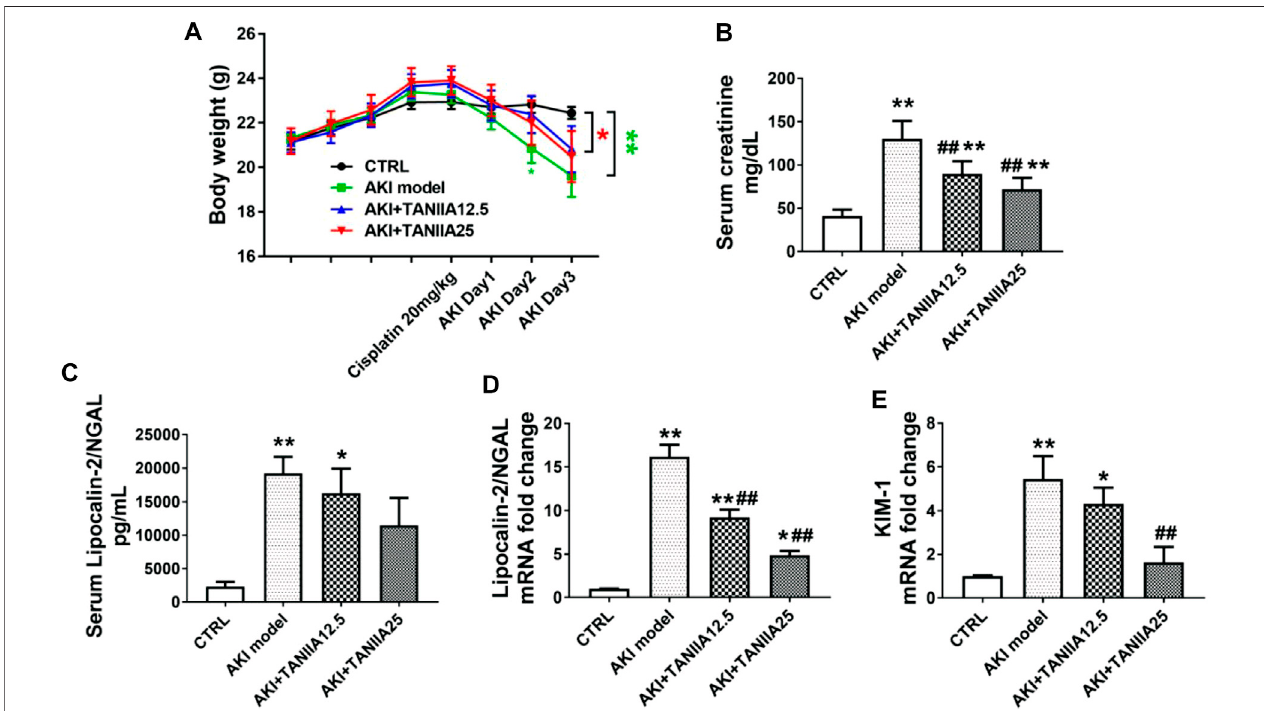
FIGURE 2 | TanIIA treatment restores renal function in cisplatin-induced AKI. (A) Body weight (g) before and after cisplatin injection. (B) Serum creatinine at 72 h aftercisplatin(20 mg/kg)injection. (C) BarchartrepresentstheserumlevelofNGAL. (D,E) mRNAlevelofNGAL,KIM-1inthekidney.Datarepresentasmean±SEM, *p < 0.05, **p < 0.01 compared with the control group ( n = 5). #p < 0.05, ##p < 0.01 compared with AKI group ( n = 5). One-way ANOVA followed by Turkey ’ s test for multiple comparisons was used for three or more groups; CTRL: 0.9% normal saline; TanIIA concentrations = 12.5 and 25 mg/kg/day; abbreviations: NGAL, neutrophil gelatinase-associated lipocalin; KIM-1, kidney injury molecule